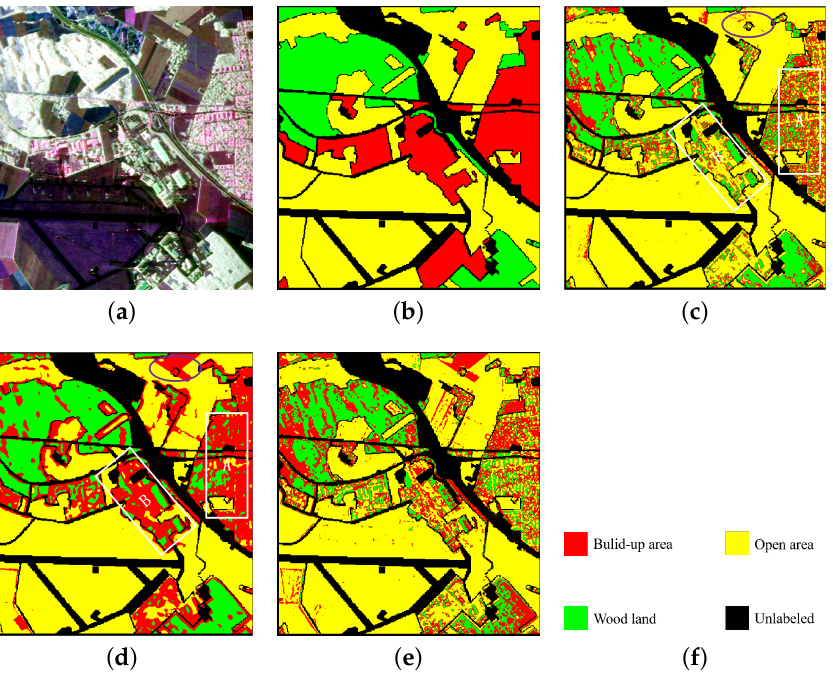
Figure 8. Experimental data of the Oberpfaffenhofen area, ground truth of the ground object and classification results with the proposed method and comparison method. Rectangles A and B are the specific comparative analysis areas of the classification maps in ( c , d ). ( a ) Pauli pseudo color image synthesized by polarimetric coherence matrix T. ( b ) The ground truth of the three objects. ( c ) The classification result of H/alpha-Wishart. ( d ) The classification result of the VQC-CAE model. ( e ) The classification result of the VQC-CAE model without Gaussian smoothing loss. ( f ) The color set of the ground truth: green for wood land (Wood), red for built-up area (Build), yellow for open area (Open), and the unlabeled pixels are